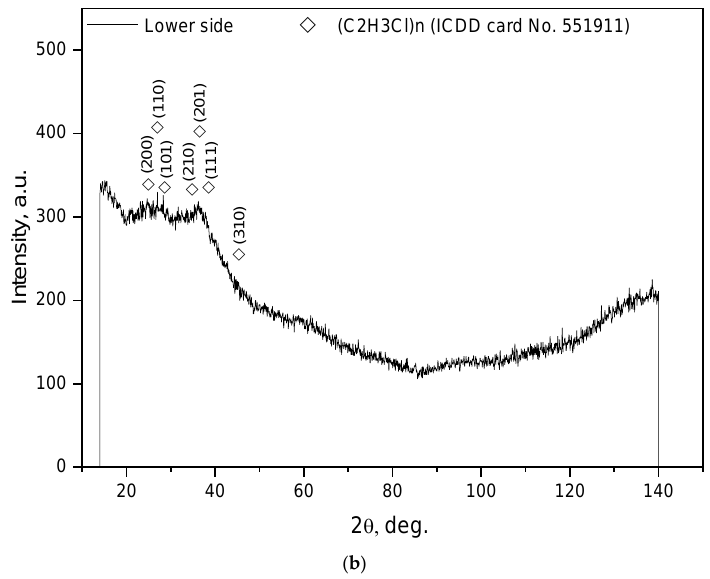
Figure 3. Characterization of the remaining sample components: ( a ) general view (original blisters and remaining components); ( b ) XRD pattern for the remaining components.